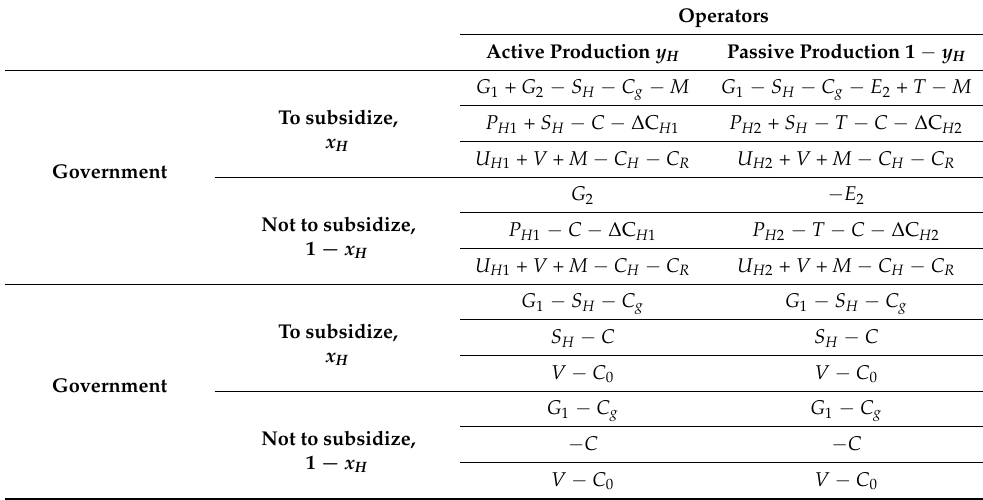
Table 1. Reward matrix in the evolutionary game among the government, operators, and consumers under the investment subsidy